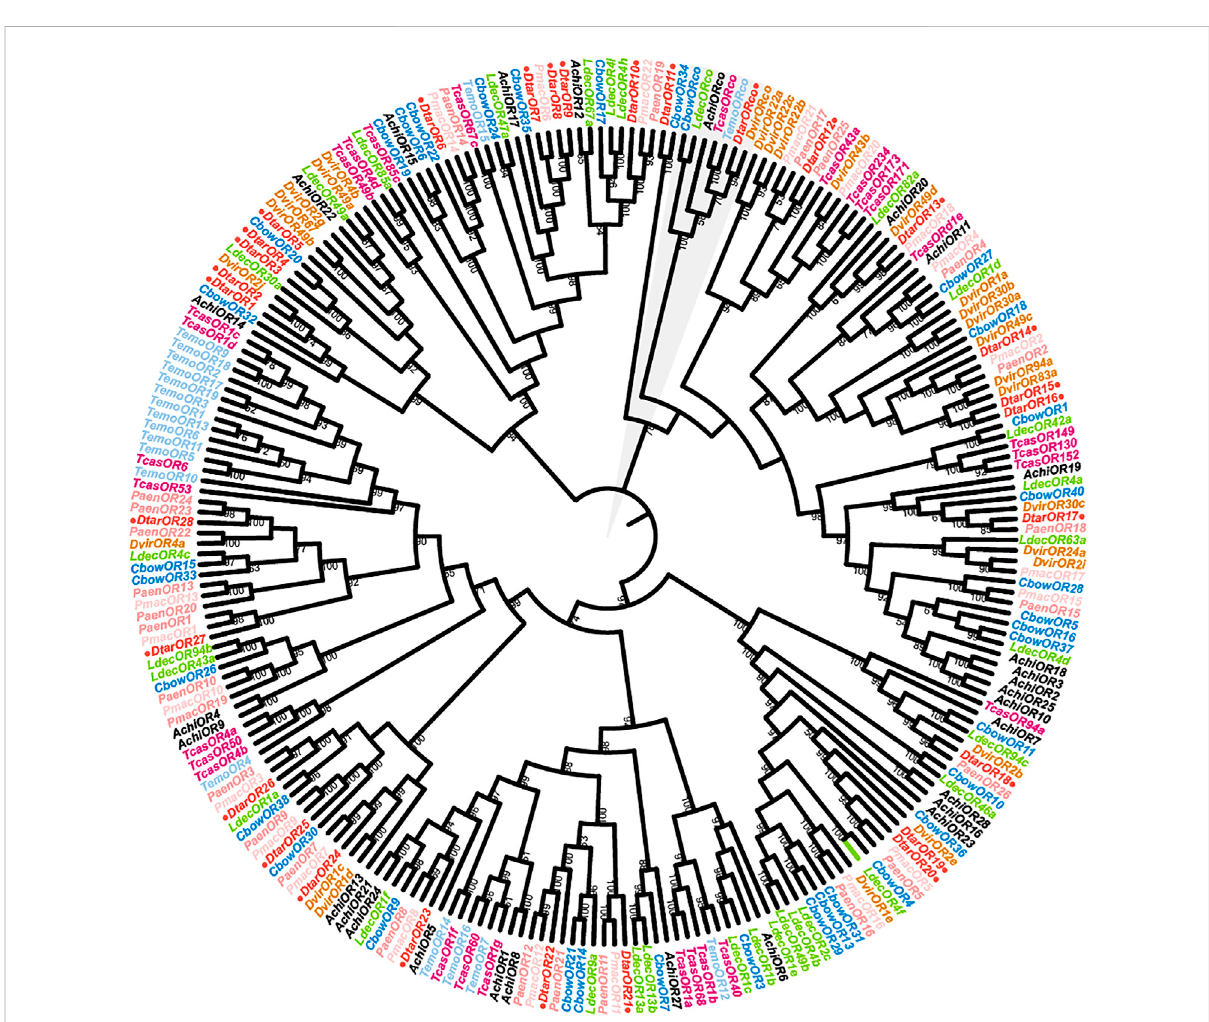
Phylogenetic tree of odorant receptor genes from D. tarsalis and other Coleoptera. Pmac, Pyrrhalta maculicollis (N = 22); Temo, Tenebrio molitor (N=19);Paem, Pyrrhaltaaenescens (N=25);Cbow, Colaphellusbowringi (N=34);Ldec, Leptinotarsadecemlineata (N=31);Dvir, Diabrotica virgifera (N = 27); Tcas, Tribolium castaneum (N = 28); Achi, Anoplophora chinensis (N =